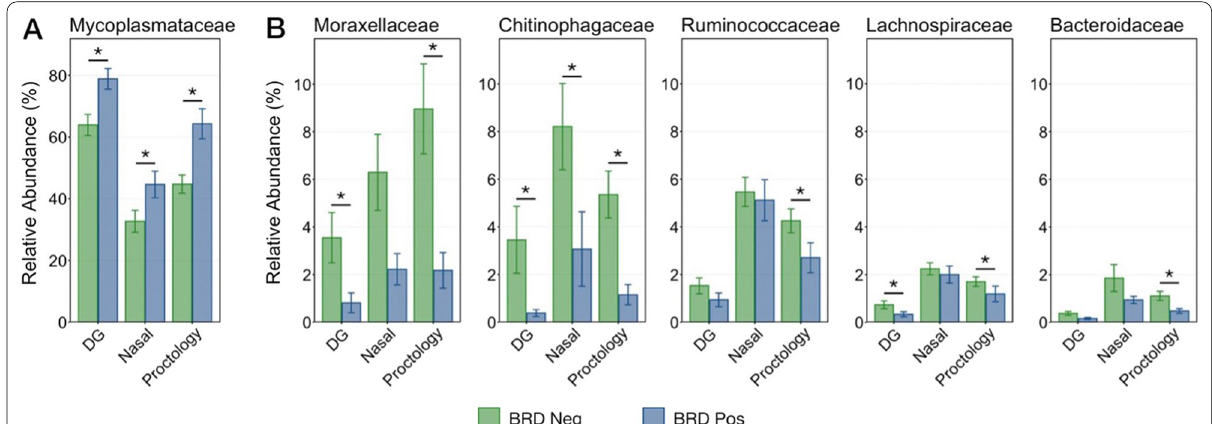
Fig. 9 Bar plot demonstrating differences in the relative abundance of microbial taxa of interest within BRD negative and BRD positive animals as collected with DG swabs, nasal swabs, or proctology swabs. Error bars display the standard error of the mean. Significant differences among relative abundances within each phylum and swab type are noted with an asterisk (Kruskal–Wallis analysis of variance by ranks, P < 0.05). Note the difference in the relative abundance scale for 4A and 4B